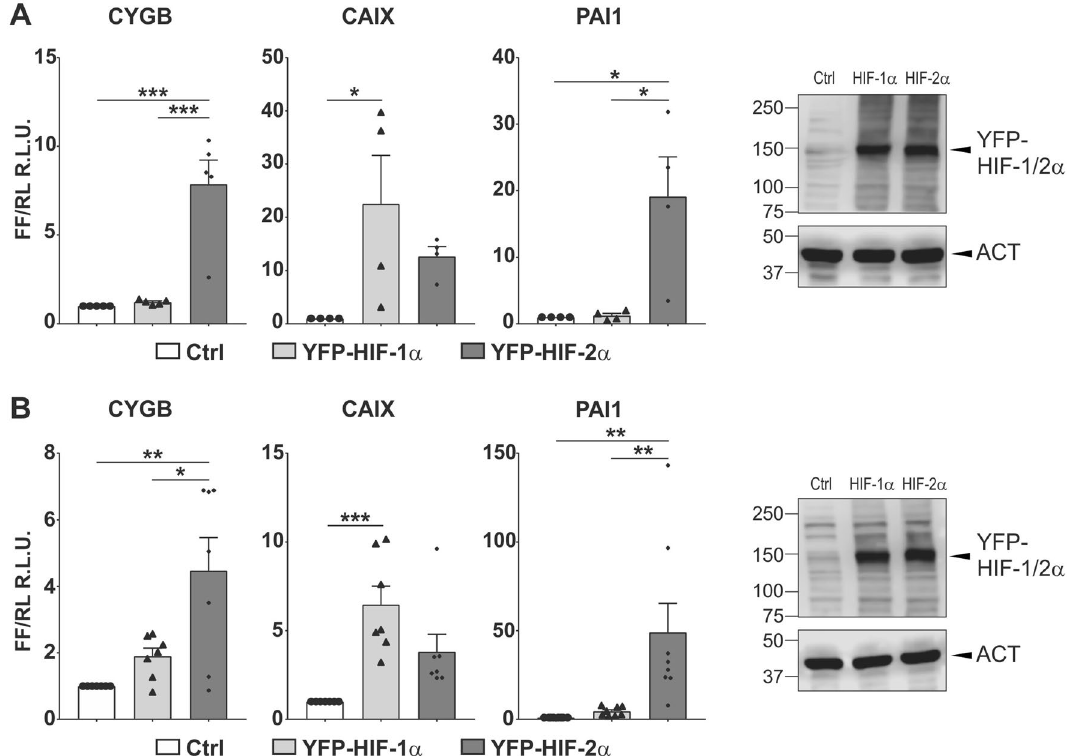
Figure 6. Reporter gene assays demonstrate HIF-2α-dependent induction of CYGB promoter-driven luciferase activity in A375 and Hep3B. A375 cells ( A ) and Hep3B cells ( B ) were transfected with CYGB promoter constructs and HIF-1α or HIF-2α isoform overexpression plasmids, as indicated. CAIX and PAI promoter constructs served as HIF-1α and HIF-2α control genes, respectively. For each cell line equal overexpression levels of YFP-HIF-1α and YFP-HIF-2α were detected by immunoblotting with a GFP antibody. Luciferase activity is reported as the induction compared to the control (Ctrl) and represents the ratio of firefly (FF) to Renilla (RL) relative light units (R.L.U.). Each column represents the mean ± SEM of four to eight different experiments performed in duplicate. One-way ANOVA (* p ≤ 0.05; ** p ≤ 0.01; *** p ≤